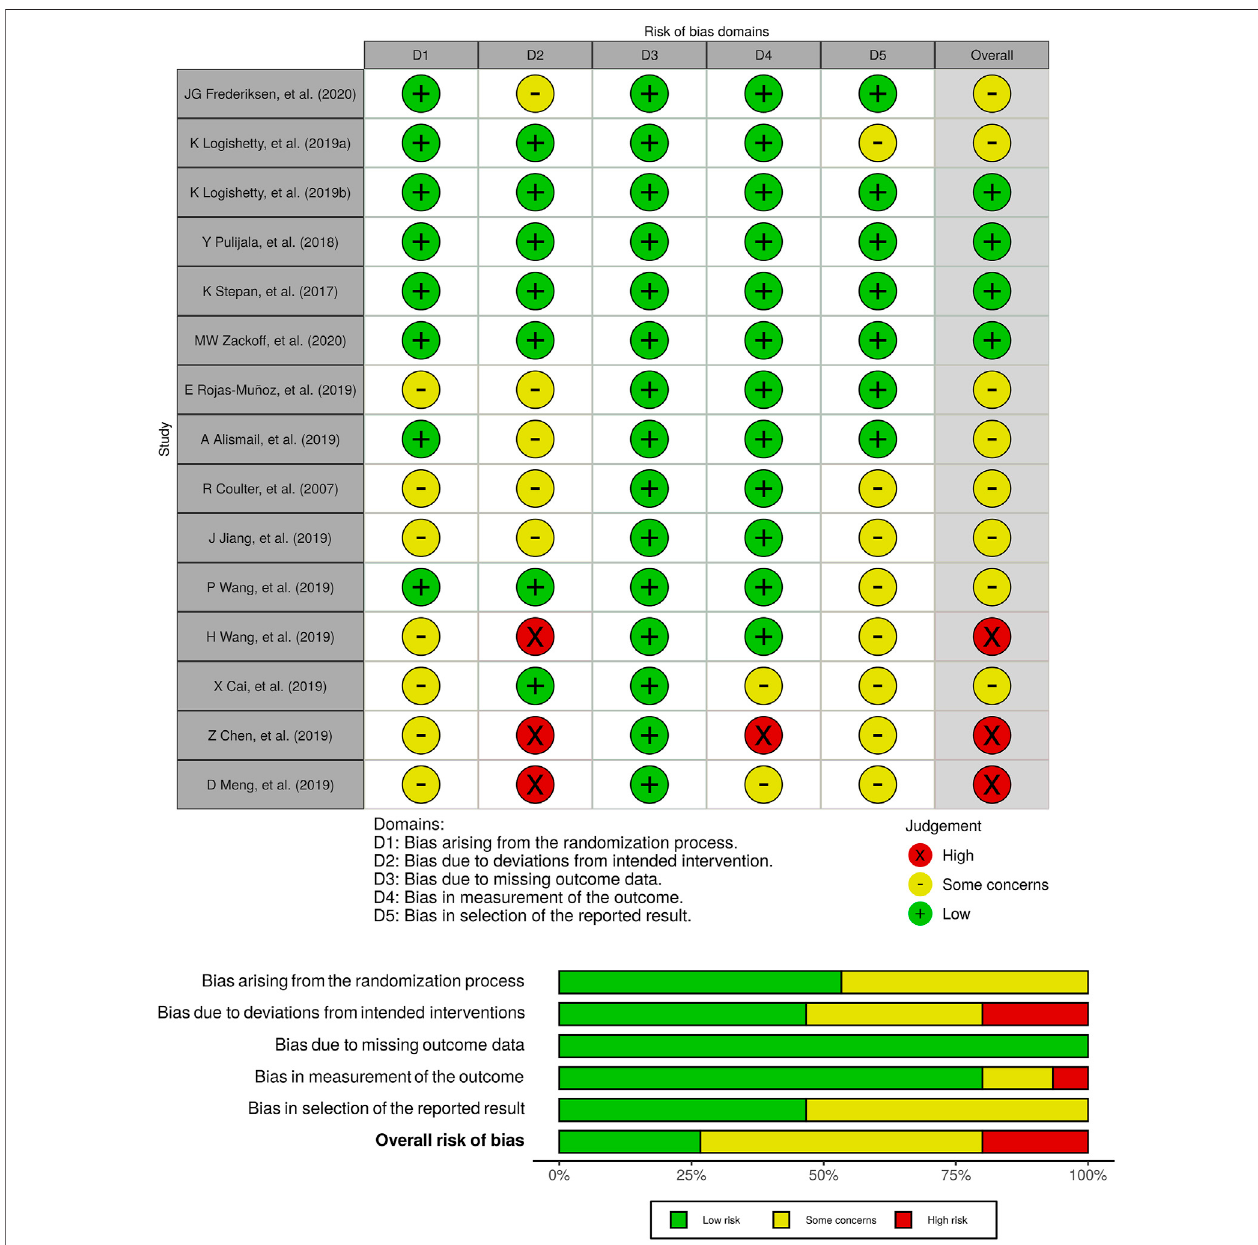
FIGURE 4 | Risk of bias